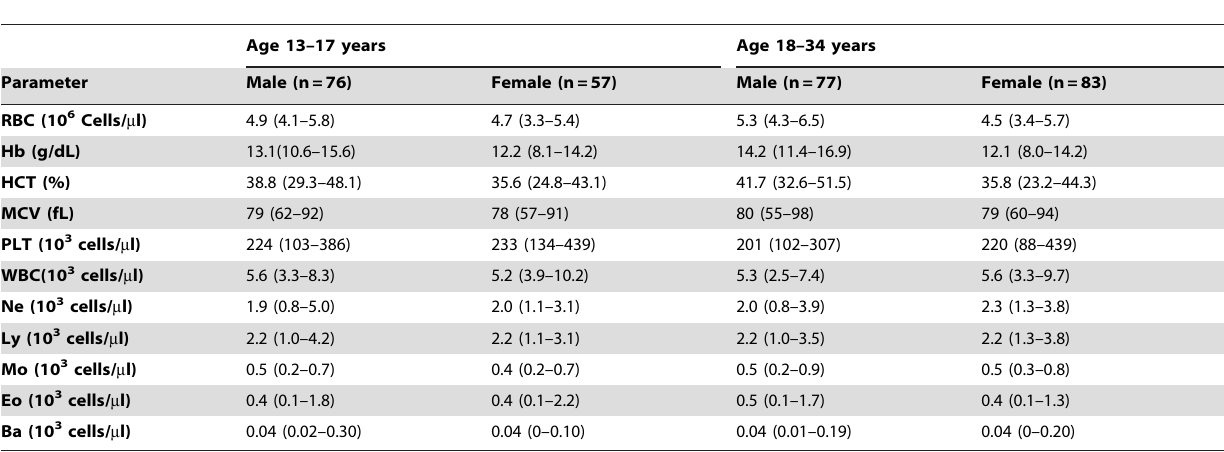
Table 1. Hematological reference values (median and 95 th -percentile) stratified by age and gender from a 13–34 years old cohort in rural western Kenya